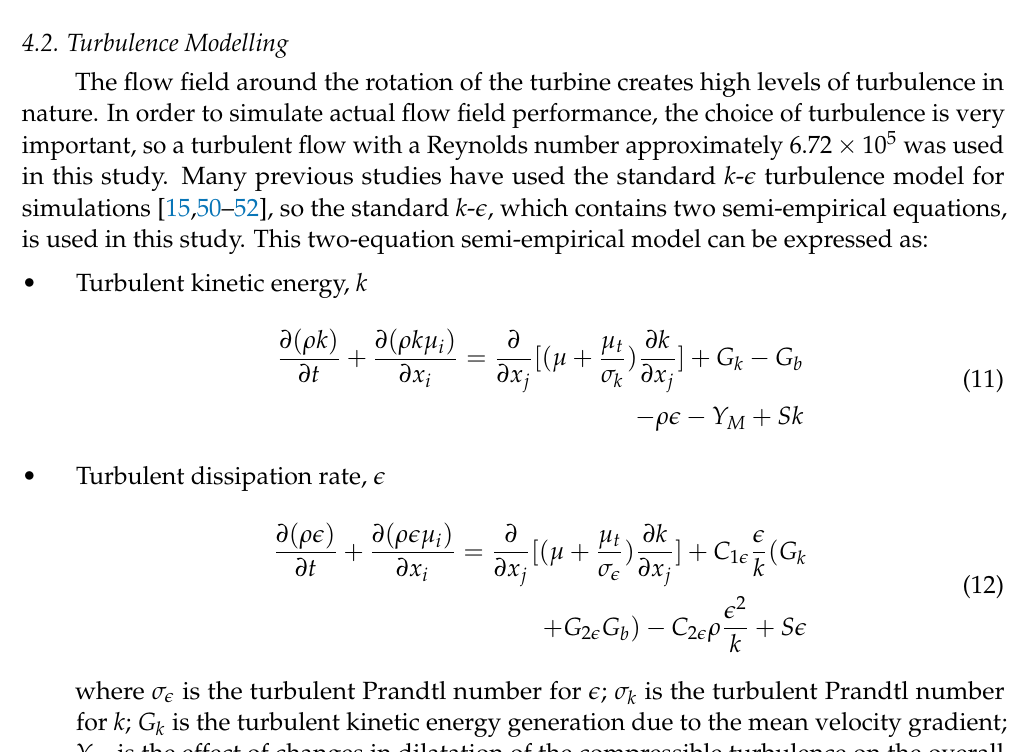
Table 1. Details of the computational settings. Characteristic Value Spatial discretization method Finite Volume Method (FVM) Convergence criteria for